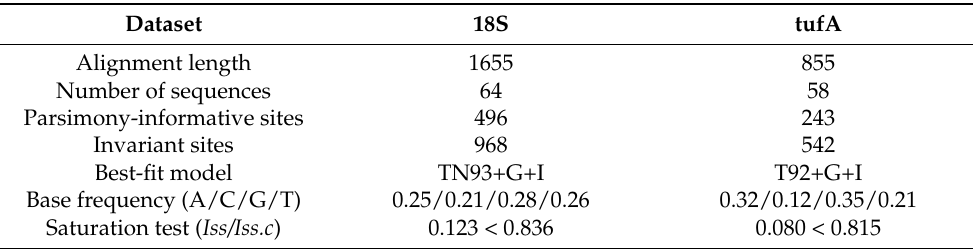
Figure 5. Maximum likelihood phylogenetic tree of Ulvales based on tufA sequences. Maximum likelihood bootstrap values and Bayesian posterior probabilities are given on nodes. Values above 0.50 for BI and 50 for ML are given. The new species in this study are shaded in gray. Table 2. Detailed information of alignment and nucleotide substitution in 18S and tufA concatenated phylogenies for ML analysis.